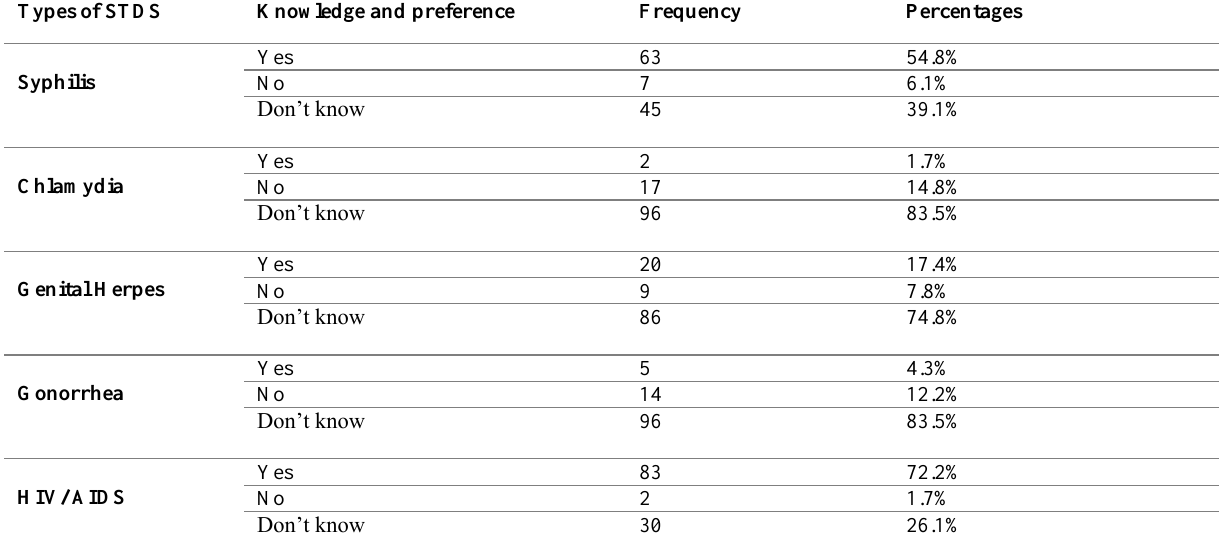
Table 1: Knowledge regarding types of Sexually Transmitted Diseases Slum women